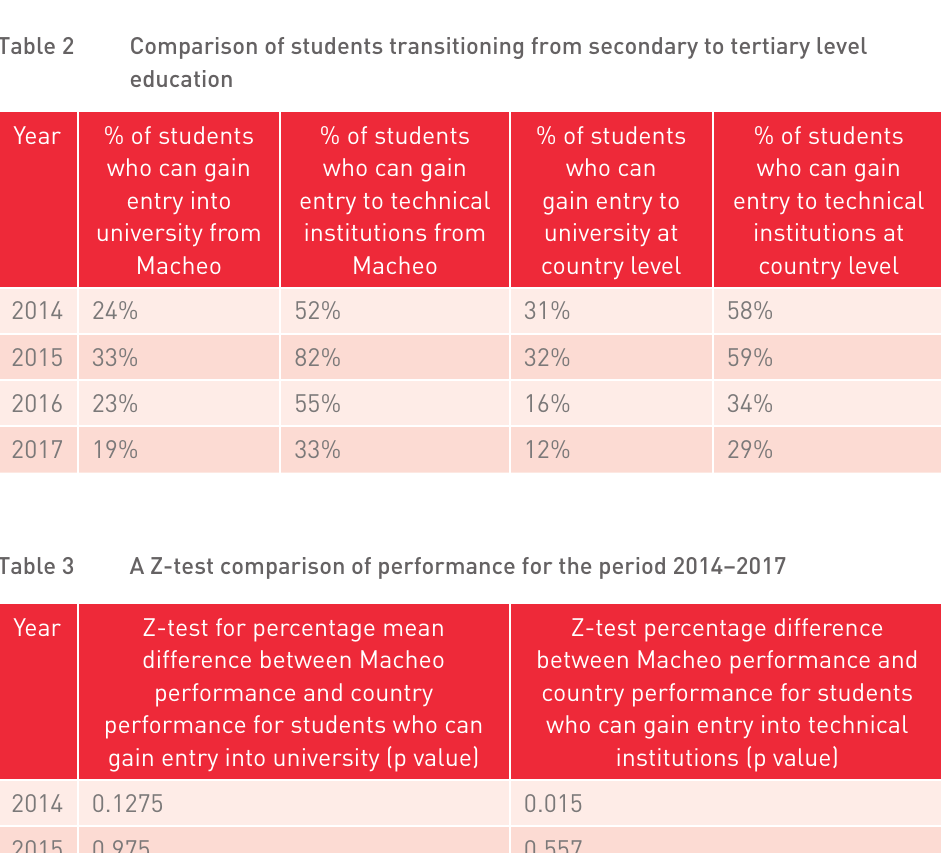
Comparison of students transitioning from secondary to tertiary level education